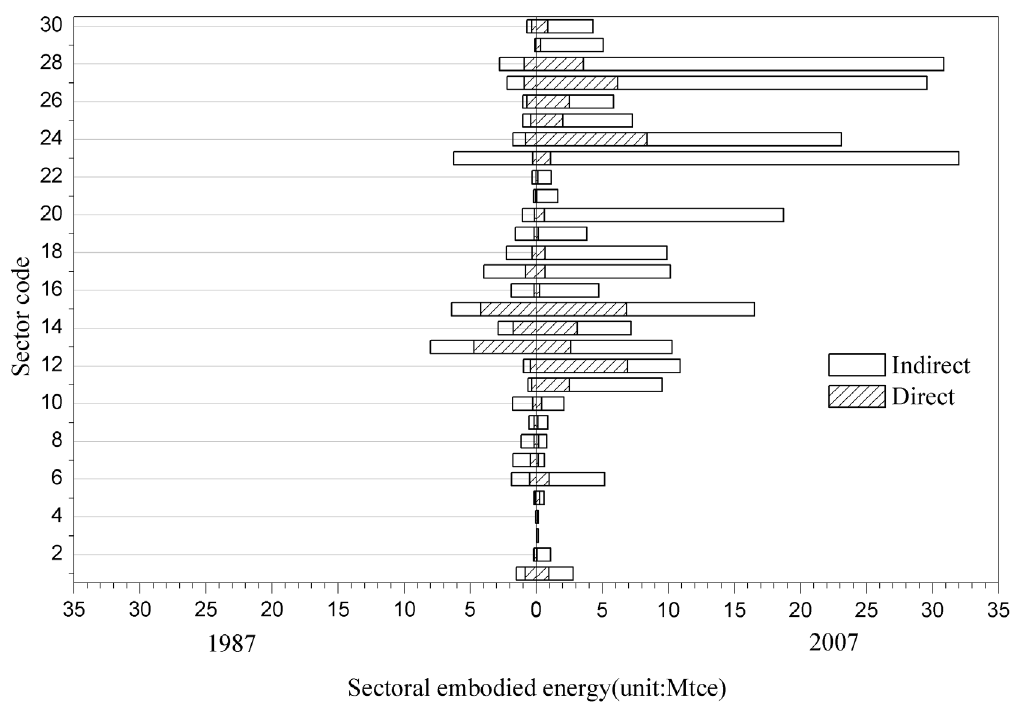
Figure 3. Sectoral distribution of embodied energy consumption between 1987 and 2007 in Beijing (see Table 2 for sector code definitions).